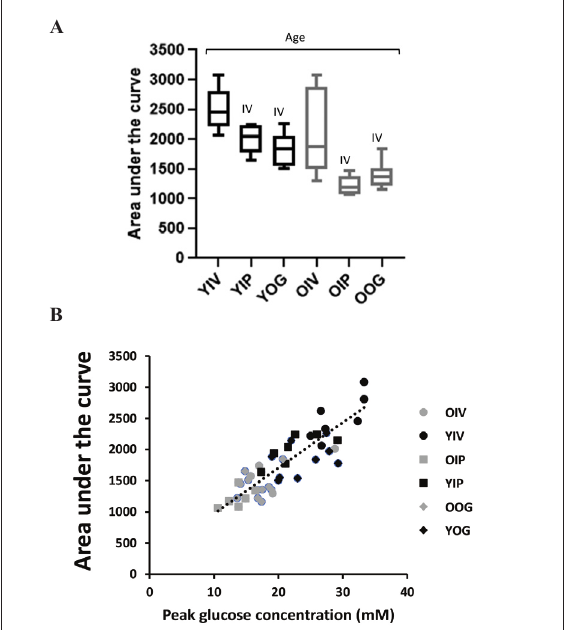
Figure 2. A) Area under the curve in arbitrary units calculated from blood glucose concentrations (mM) at 0, 15, 30, 60, 90 and 120 minutes after administration of bolus glucose intravenously (IV) via the tail vein, intraperitoneally (IP) or via oral gavage (OG) in young (Y) and old (O) mice. Age: indicates that at any timepoint (except time 0 min) old values were lower than corresponding young values at p<0.001; IV: indicates significantly different from IV at p<0.001; Data is presented as mean, min, max. B) Correlation between area under the curve and peak glucose concentration during the test. R 2 adj =0.774;